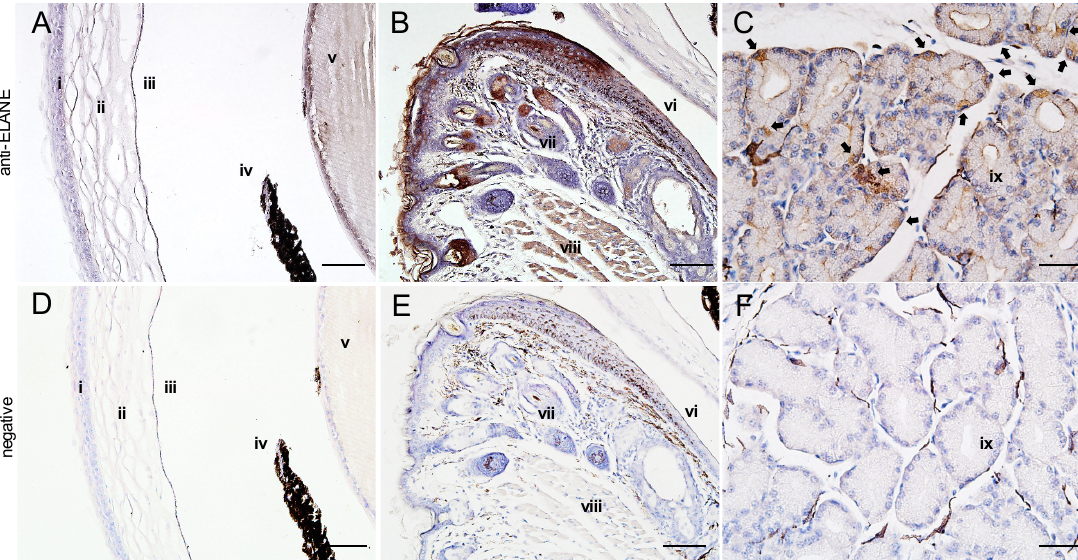
Figure 6. Immunohistochemical analysis of the cornea and eyelid of PG1 transgenic mice using anti-ELANE antibodies. ( A – F ) are the results of anti-ELANE immunohistochemistry for the corneal region, eyelid, and Harderian gland, respectively. Antibody reactivity is indicated in brown by diaminobenzidine staining. Sebaceous glands in the eye lids (( B ), 200×) and type-I cell-like cells in Harderian glands (( C ), 400×, black arrows indicated stained cells) showed positive signals for ELANE. The staining pattern of wild-type mice with anti-ELANE was identical to that of PG1 transgenic mice. ( A – C ): anti-ELANE antibodies. ( D – F ): negative controls. (i) corneal epithelium, (ii) corneal stroma, (iii) corneal endothelium, (iv) iris, (v) lens, (vi) palpebral conjunctiva, (vii) hair follicle, (viii) orbicularis oculi muscle, (ix) Harderian gland. Scale bars represent 100 μm.